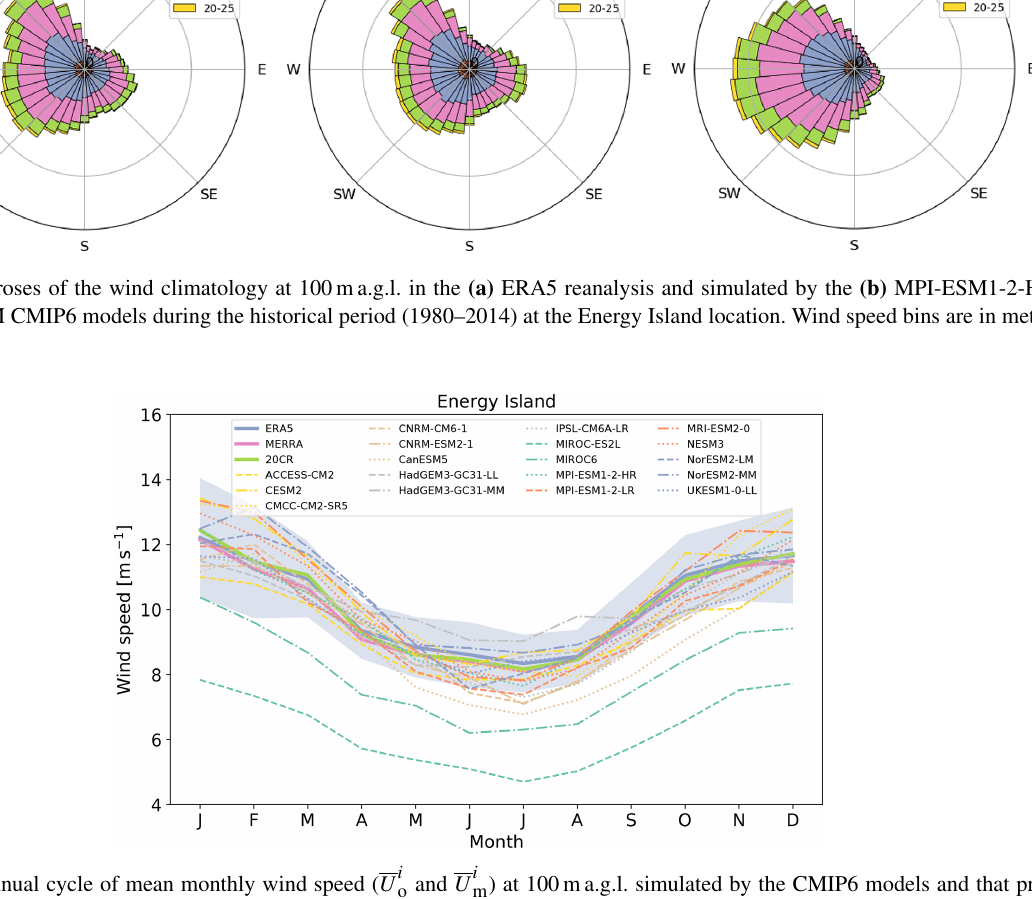
Figure 5. The annual cycle of mean monthly wind speed ( U by the global reanalyses during the full historical period (1980–2014) for the Energy Island location. The shaded area is the ± 1 standard deviation of the monthly means for the ERA5